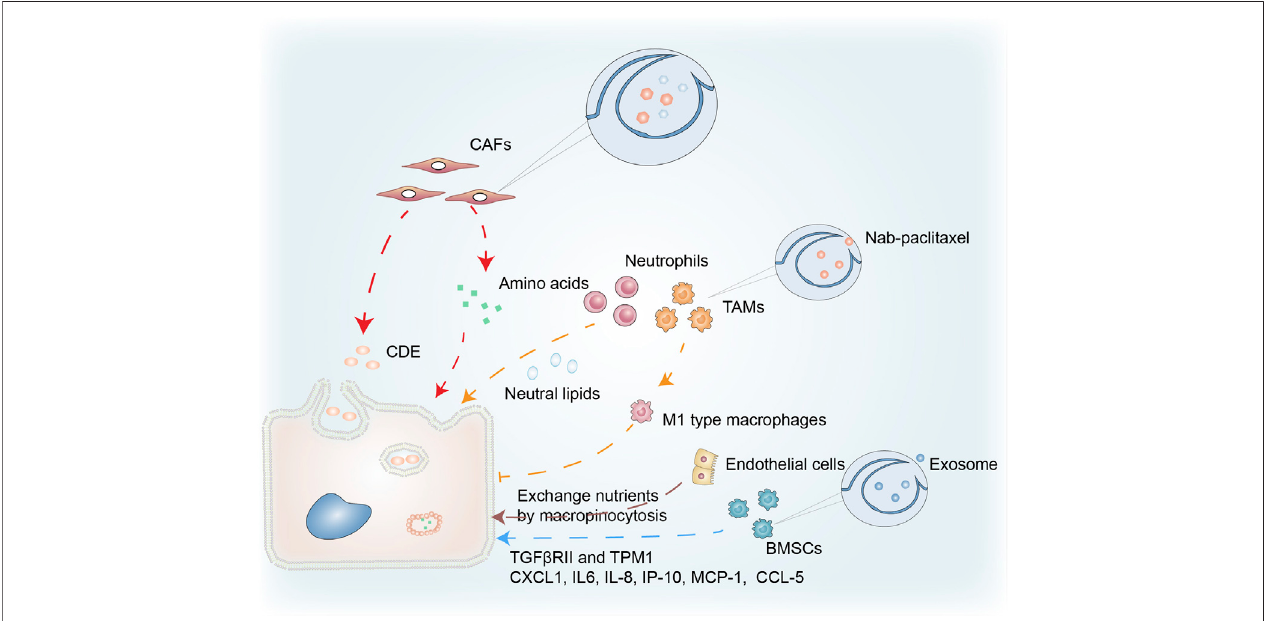
FIGURE 4 | Macropinocytosis in the tumor microenvironment. Macropinocytosis in CAFs provides PDAC with a source of amino acids, while CDEs taken up by cancer cells through pathways similar to macropinocytosis promote tumor growth. Neutral lipids accumulating in lung neutrophils are transferred to metastatic tumor cells via themacropinocytosis-lysosomepathway, enhancingtheirsurvivaland proliferation. Nab-paclitaxelabsorbed via macropinocytosis enhances thepolarizationof M1-type macrophages and the inhibition of tumor cells. Endothelial cells in PCs have characteristics that facilitate macropinocytosis that promotes cancer growth. Macropinocytosis by BMSCs is important in cancer progression via uptake of